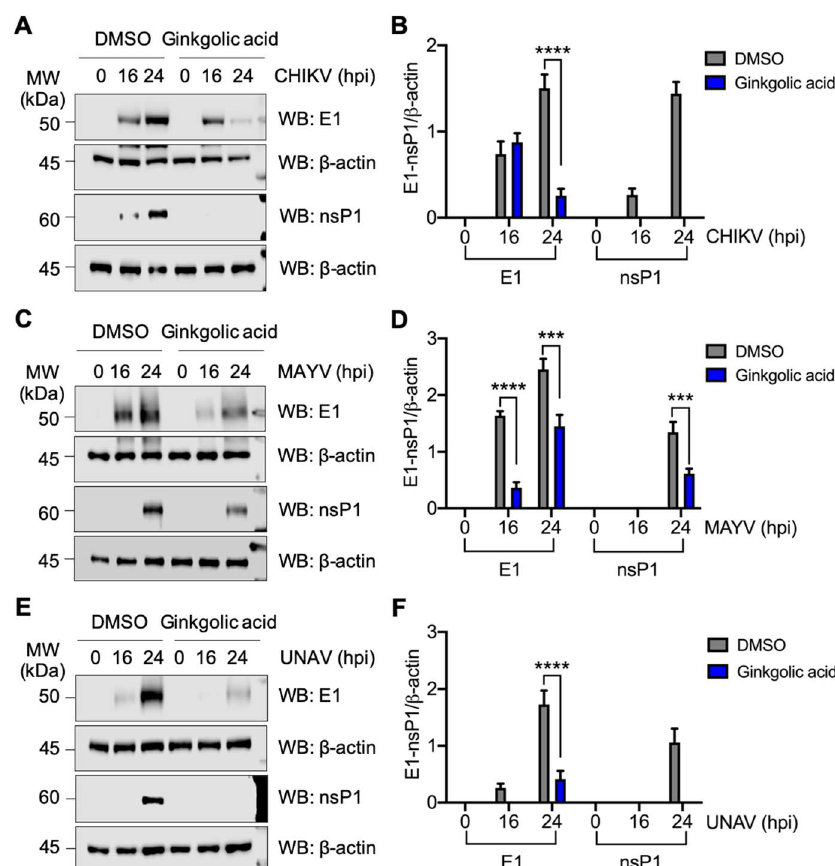
Figure 5. Ginkgolic acid affects alphavirus protein expression. Vero or HeLa cells were infected with CHIKV ( A ), MAYV ( C ), or UNAV ( E ) at an MOI of 10. After 1 h of virus absorption, Ginkgolic acid or DMSO were applied to the cells. At different times post-infection, the levels of E1 and nsP1 proteins were assessed by Western blot (WB). β-actin protein was used as a loading control. MW: Molecular weight. kDa: kilodaltons. B , D , F . Intensity bands for both E1 and nsP1 proteins were quantified using ImageJ software and normalized with β-actin protein. Data were analyzed with the Two-way ANOVA test. Statistically significant differences are shown: ***p < 0.001; ****p < 0.0001.